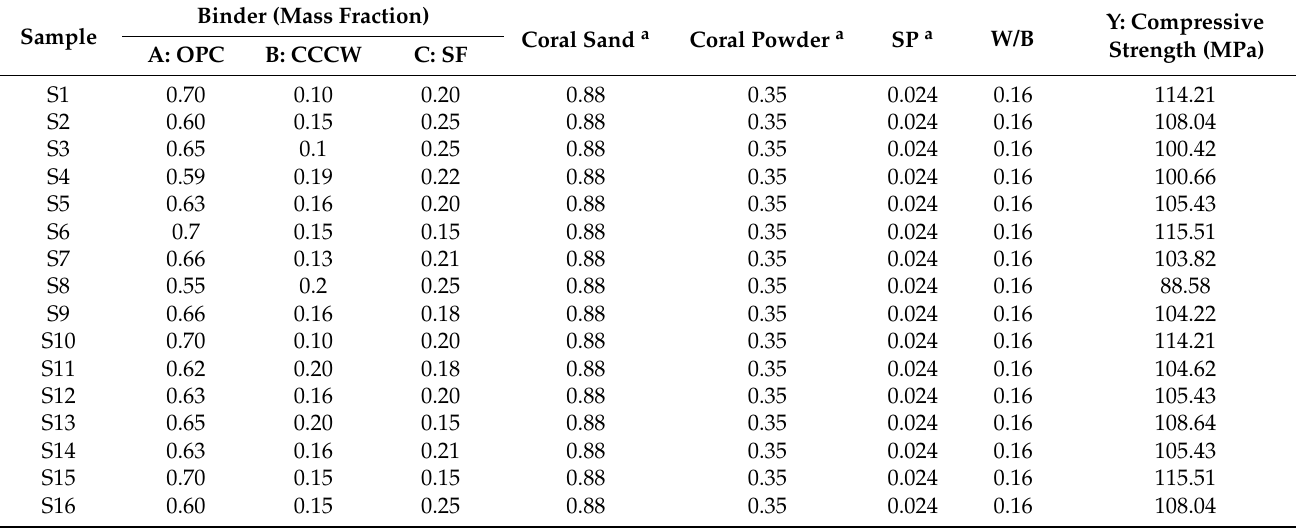
Table 6. Mix proportions and compressive strengths of optimal mixture